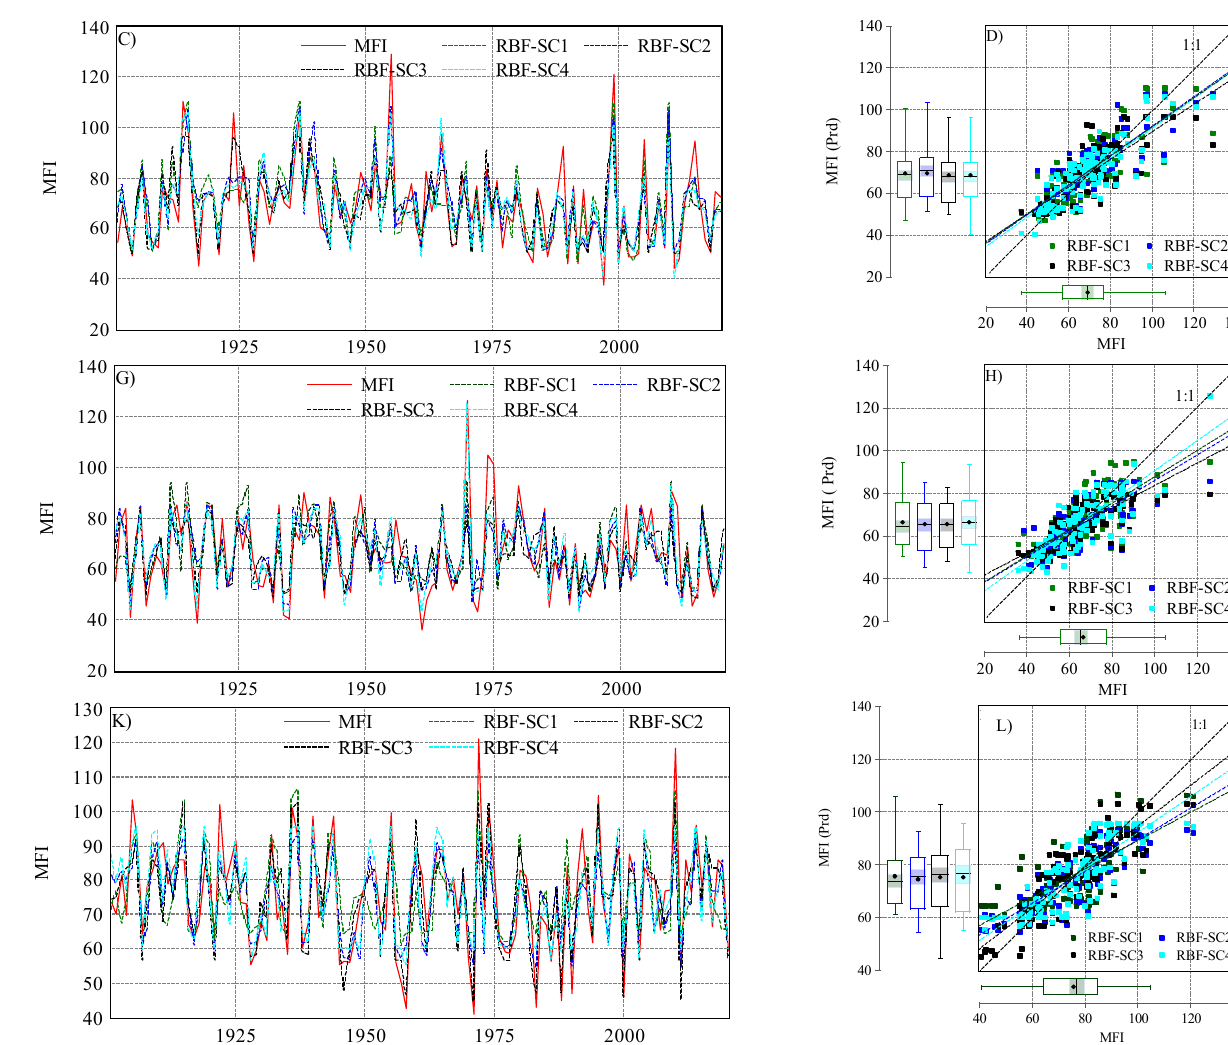
Figure 6. The output of ANN–RBF algorithm (predicted MFI) and observed one in the studied station under four scenarios (SC1, SC2, SC3, and SC4): ( C ) evolution of observed and predicted MFI in Budapest (1901–2020); ( D ) scatter plot MFI observed vs. MFI predicted in Budapest; ( G ) evolution of observed and predicted MFI in Debrecen (1901–2020); ( H ) scatter plot MFI calculated vs. MFI predicted in Debrecen; ( K ) evolution of observed and predicted MFI in Pecs (1901–2020); ( L ) scatter plot MFI calculated vs. MFI predicted in Pecs.